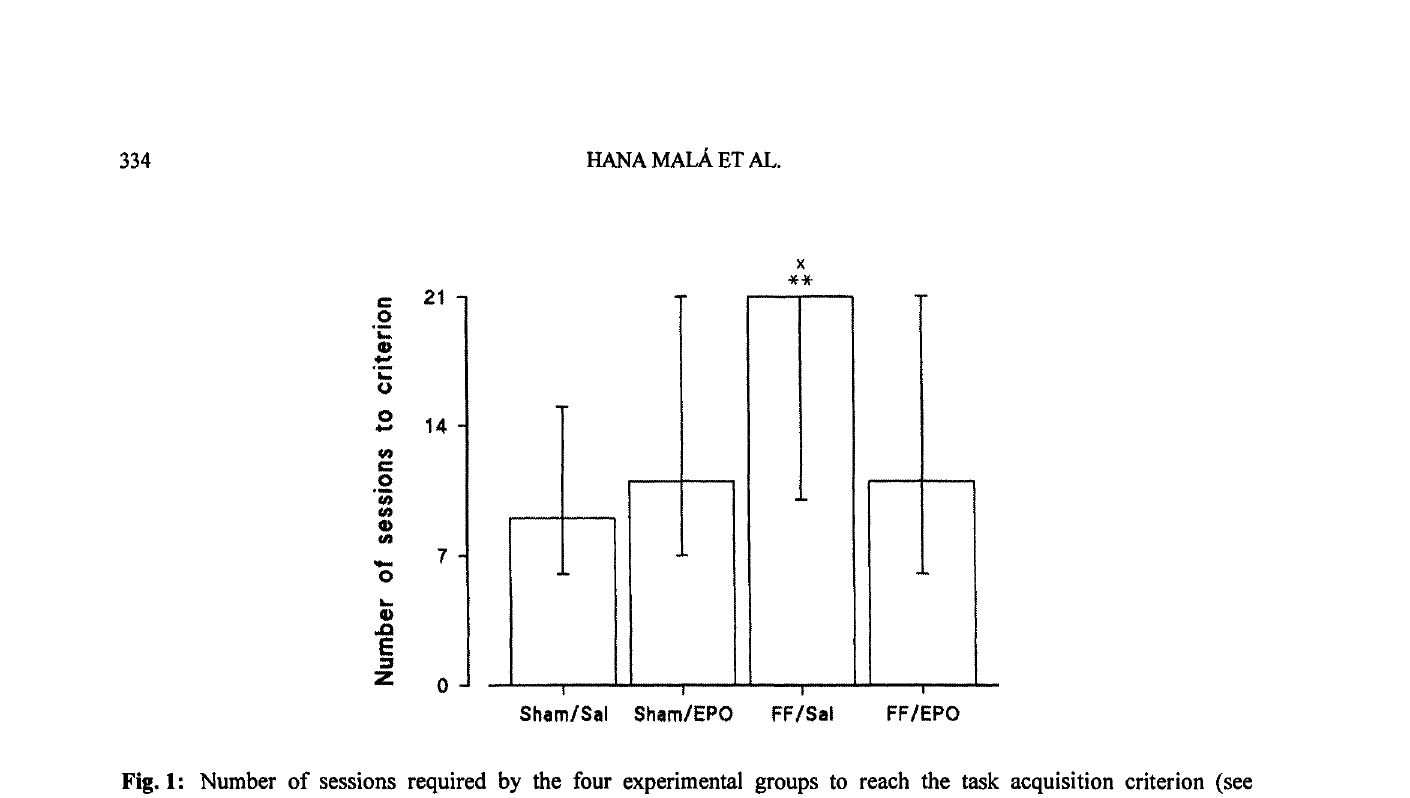
Fig. 1" Number of sessions required by the four experimental groups to reach the task acquisition criterion (see Experimental section for details). Values are given as medians with ranges. **" Significantly (p < 0.01) different from the Sham/Sal group, x: Significantly (p < 0.05) different from the FF/EPO